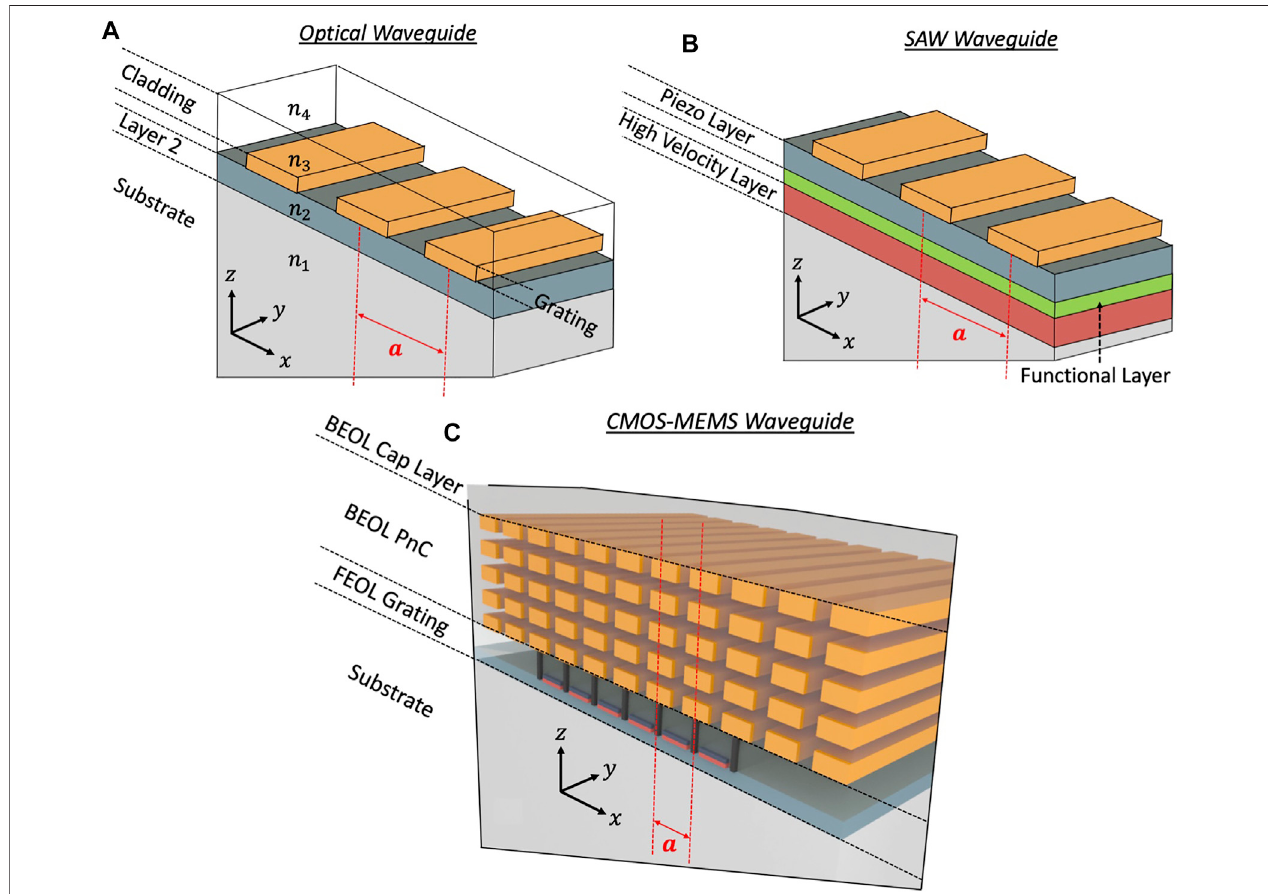
FIGURE 2 | (A) Photonic SWG waveguide with lattice constant a and the effective refractive index of the grating structure comprising of n 3 and n 4 higher than the indices n 1 , n 2 and n 3 of the surrounding media. (B) IHP SAW grating waveguide structure having a lattice constant a depicting the piezoelectric amd patterned metal layers atop functional and high-velocity layers. (C) CMOS phononic waveguide grating structure with patterned BEOL PnC and lattice constant a .